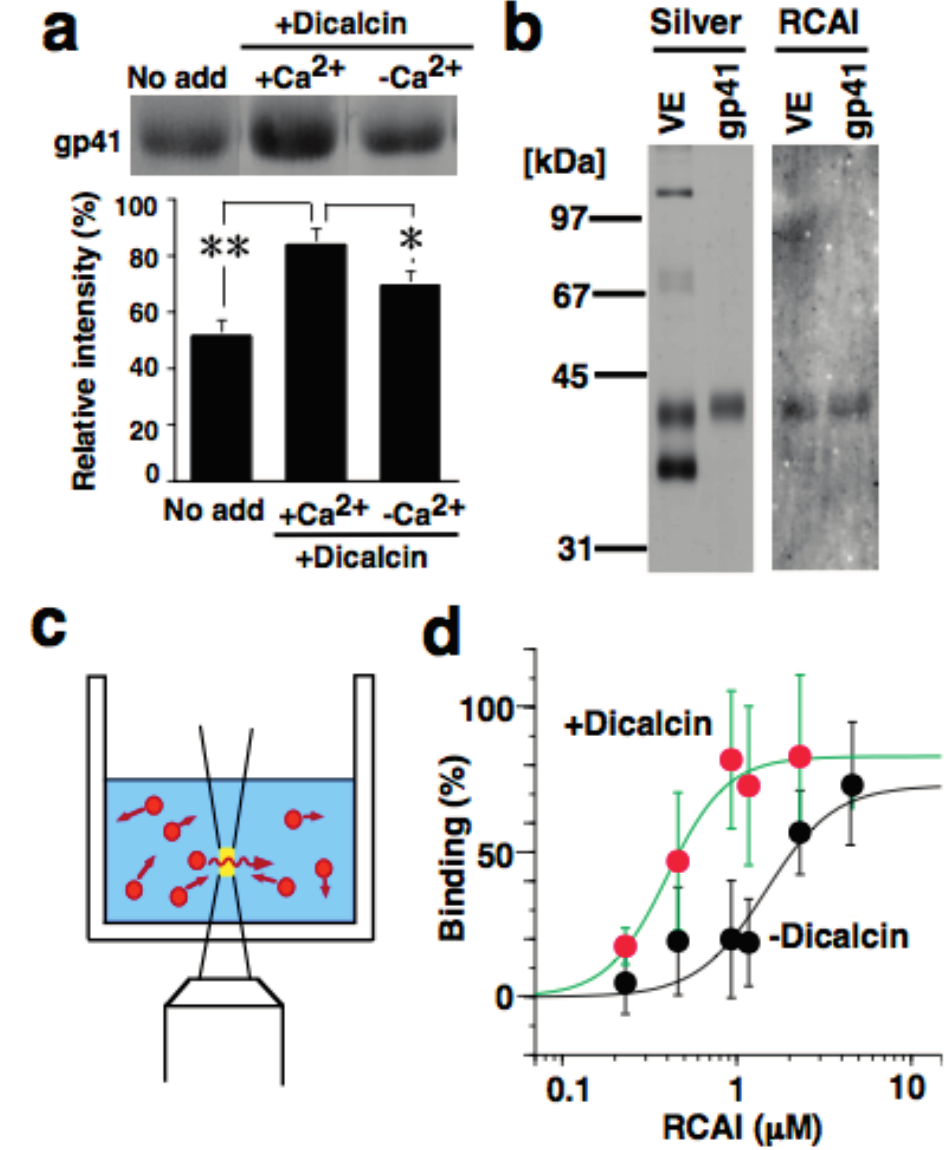
Figure 2. Dicalcin-binding to frog ZPC increases the RCA-I reactivity of ZPC. ( a ) Blots of frog ZP proteins were preincubated in the presence or absence of dicalcin, followed by incubation with rhodamine-labeled RCA-I (upper). The normalized intensity is also shown (lower, n = 8; *, p = 0.06; **, p = 0.002); ( b ) Isolation of frog ZPC. Silver, silver-stained frog ZP proteins and isolated ZPC; RCA-I, blot with RCA-I; ( c ) Schematic representation of the fluorescent signal measurement. A fluorescent signal of the diffusing molecule (red) was detected within a small defined confocal volume (yellow) of the well. Autocorrelation analysis of the fluctuating fluorescent signal estimates the diffusion time of fluorescent molecules and distinguishes small fast-diffusing ( i.e ., free fluorescent molecules) and large slow-moving (target-bound molecules) molecules; this enabled us to investigate the stoichiometry of the binding; ( d ) The normalized binding activity of isolated fluorescently labeled ZPC to RCA-I. Reproduced from Miwa et al ., (2010) [12] with permission of the